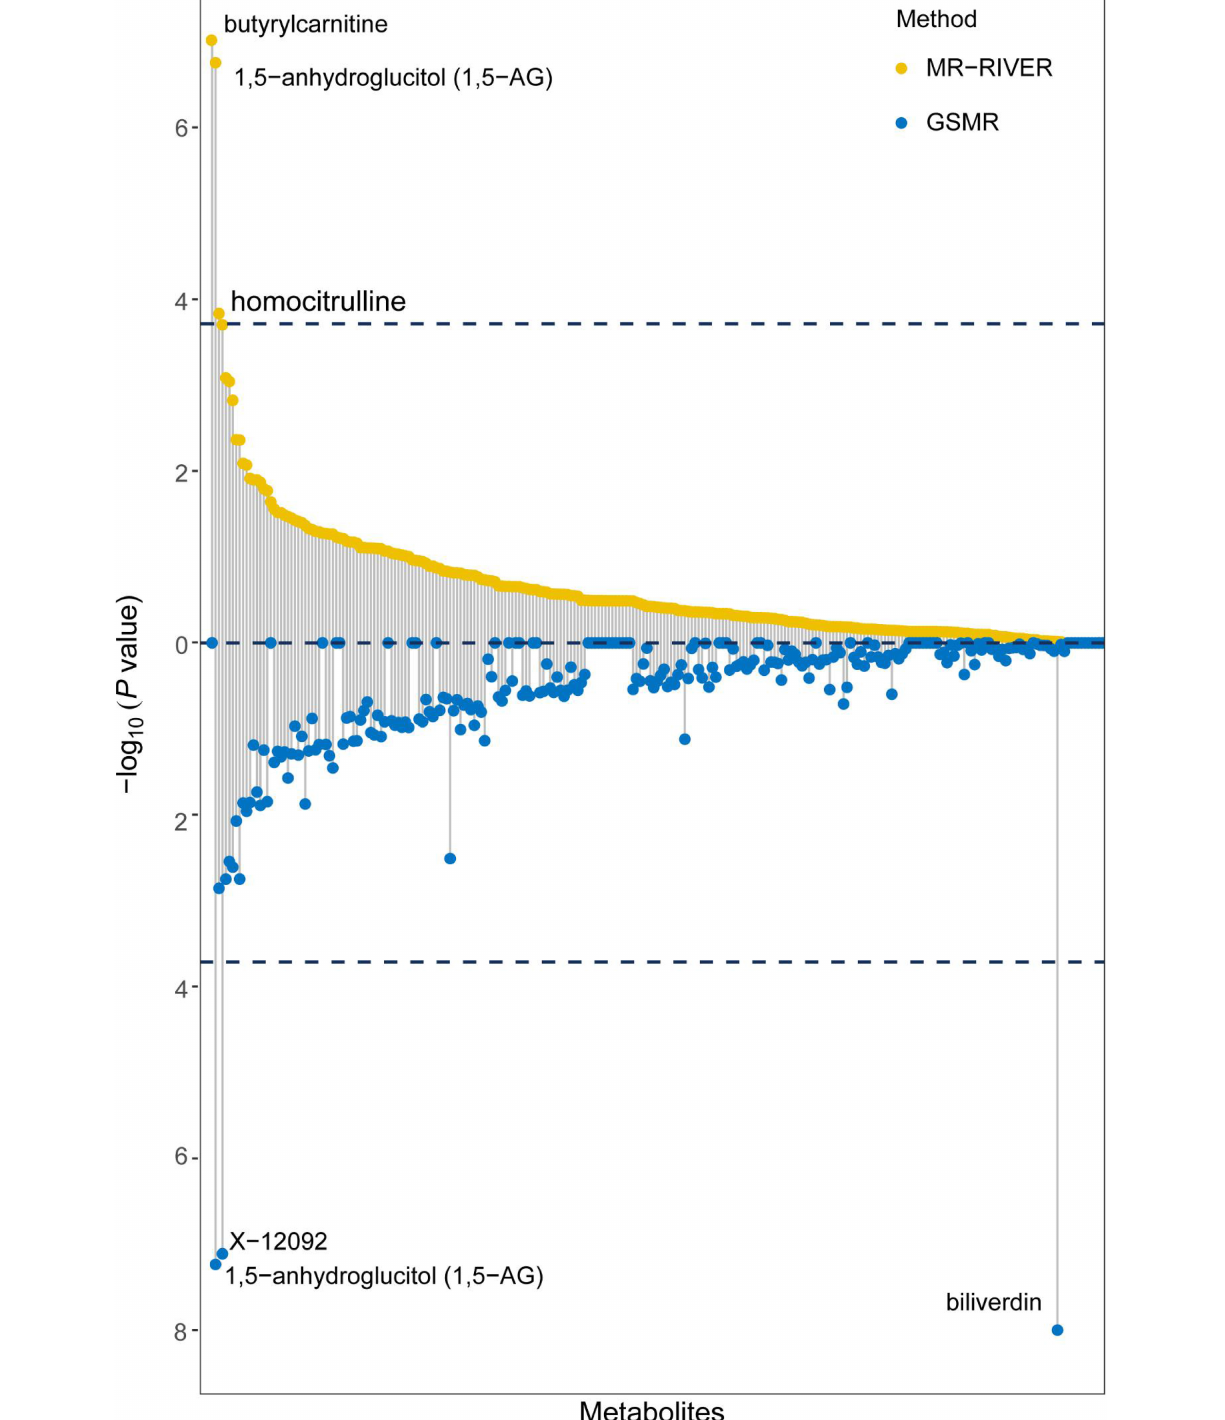
Frontiers in Genetics |